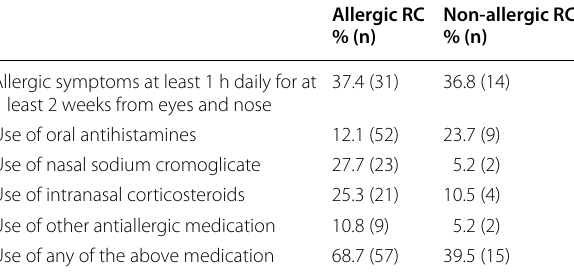
Table 2 Symptoms score and use of medication in